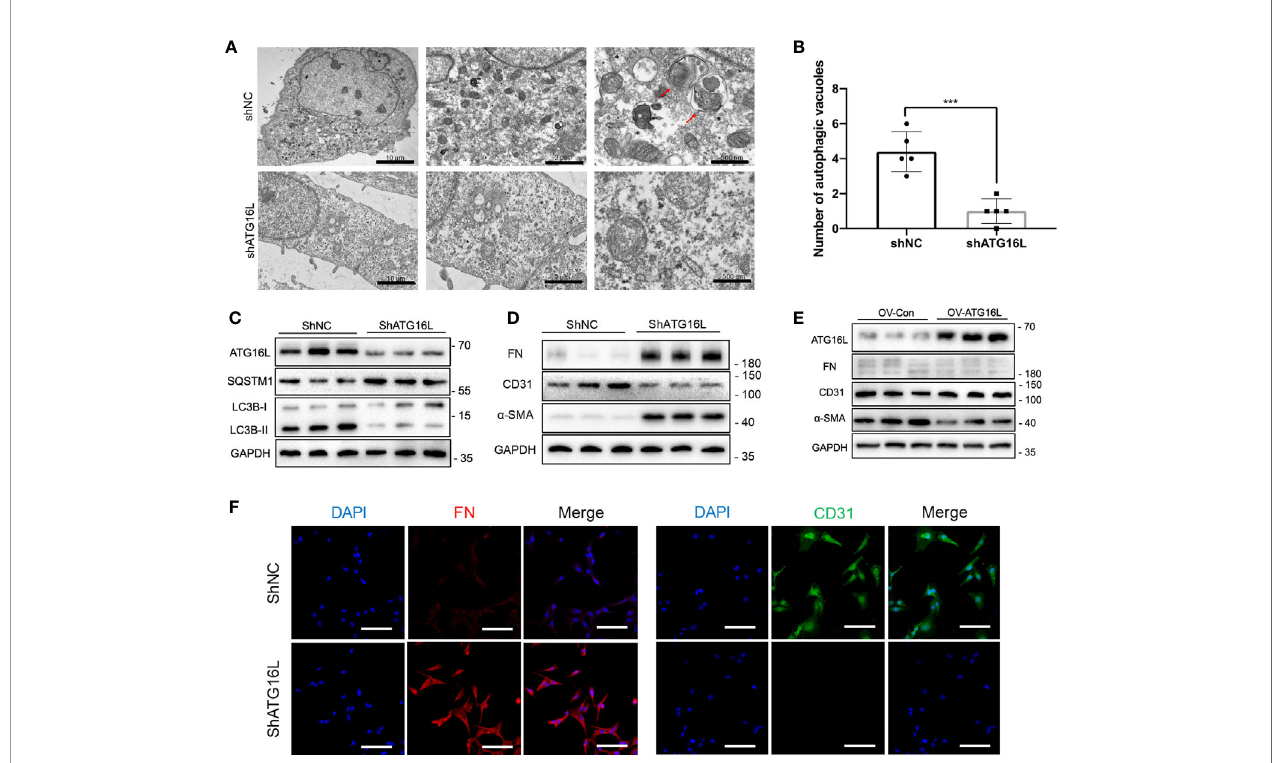
FIGURE 4 | Effects on autophagy and progression of EndMT in HRGECs after knockdown of ATG16L. (A) Representative TEM images of autophagic vacuoles (red arrow) were shown in shNC group and shATG16L group (n=5) (scale bar: 10 m m, 2 m m and 500 m m). (B) Qualitative analysis of the number of autophagic vacuoles from two groups under TEM were shown. (*** P < 0.001, Student t test.) (C) Western blot assay results of the ATG16L, SQSTM1 and LC3BI/II proteins in HRGECs transfected with shNC or shATG16L. (n=5) (D) Expressions of FN, a -SMA and CD31 protein in HRGECs transfected with shNC or shATG16L. (n=5) (E) Expressions of ATG16L, FN, a -SMA and CD31 protein in HRGECs overexpressed of ATG16L or not. (n=5) (F) Representative images of IF staining of FN and CD31 in HRGECs transfected with shNC or shATG16L. Scale bar: 20 m m